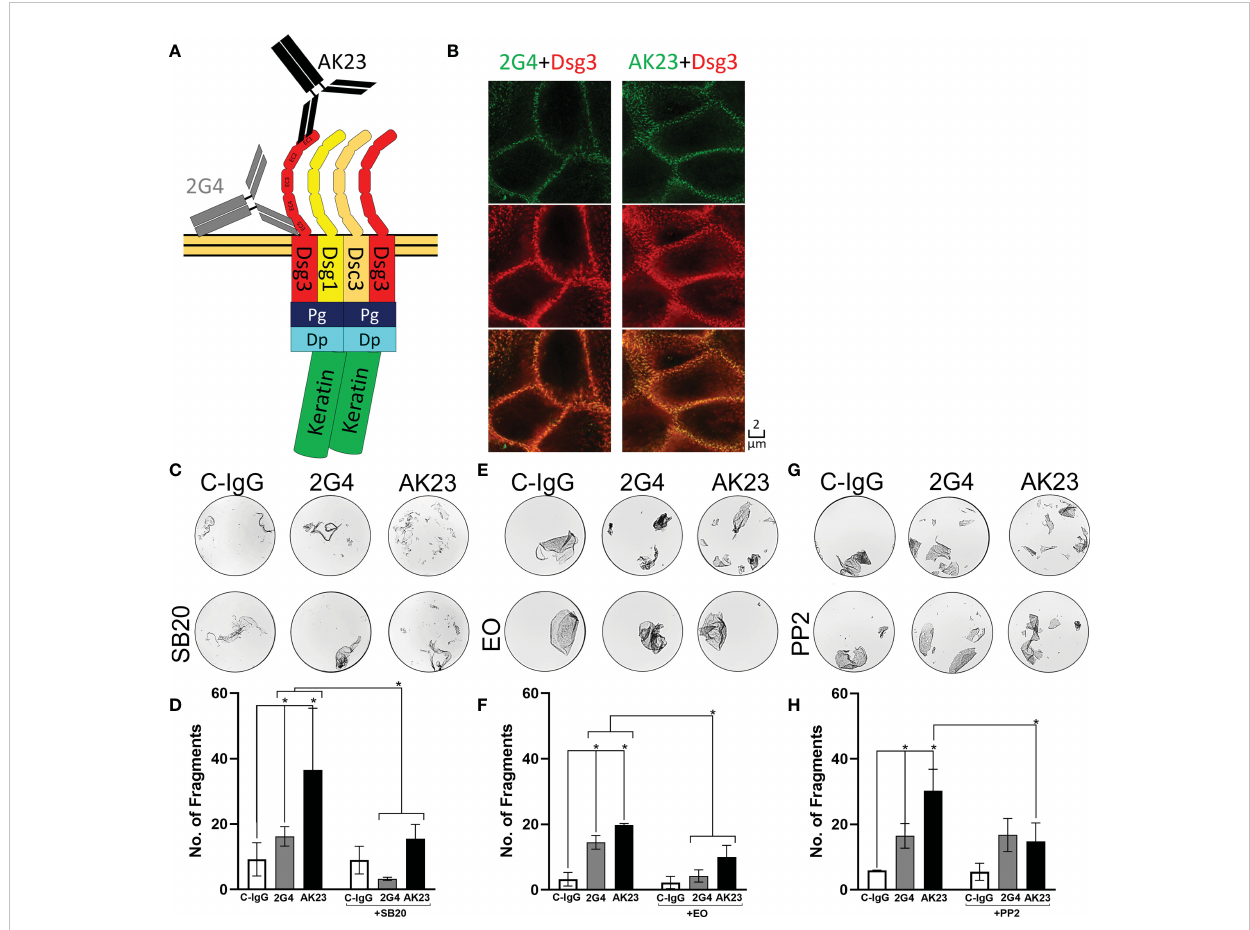
FIGURE 1 2G4 is a pathogenic Dsg3 speci fi c IgG. (A) Schematic depiction of binding positions of AK23 (Black), directed against the EC1 domain and 2G4 (Grey) directed against the EC5 domain of Dsg3, on a desmosome-bound Dsg3. (B) Co-staining of either 2G4 or AK23 (green) with Dsg3 (intracellular domain, red) and an overlay of both channels in HaCaT cells after 24 hours incubation with the IgGs (1:50), imaged with the STED microscope (N=4). (C) Representative images of dispase-based dissociation assay results in HaCaT cells. Vehicle control (left) pre-treated with SB20 (60